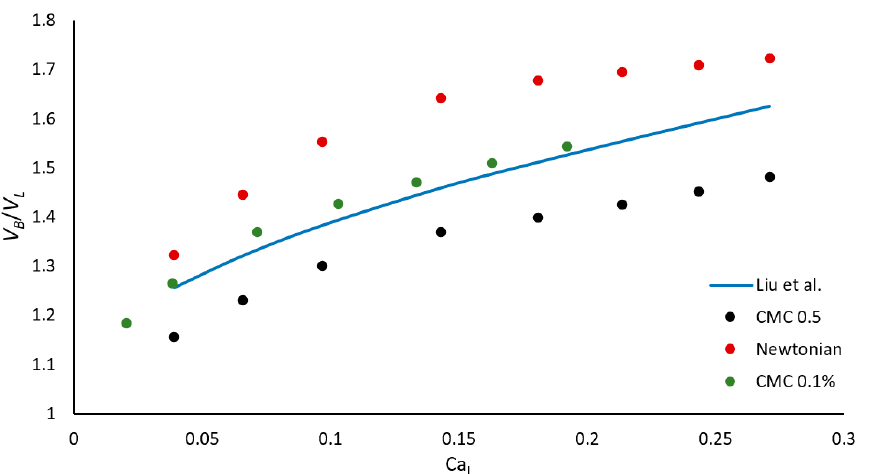
Figure 5. Bubble velocity normalized by the liquid velocity as a function of the liquid capillary number. The numerical results are for bubbles flowing in CMC solutions (0.1% and 0.5%) and in a Newtonian liquid with a viscosity corresponding to the characteristic shear rate. The theoretical predictions were based on the Liu et al. [37] correlation. The presented numerical data concerns the systems with a channel of D = 100 μ m.